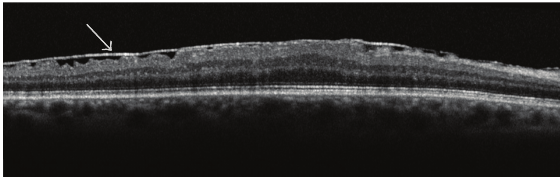
Figure 8: Lamellar hole with intact photoreceptors.